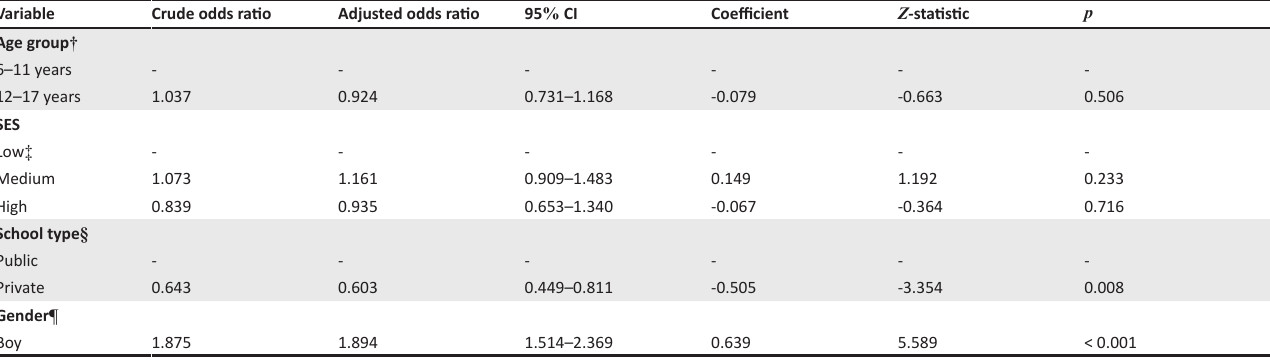
TABLE 7: Logistic regression analysis of the relationship between age group, socio-economic status, school type, gender and prevalence of conjunctivitis. Variable Crude odds